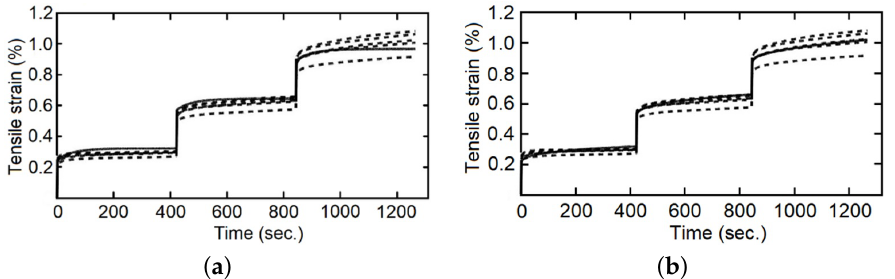
Figure 11. Tensile strain for staggered fluency test, five specimens with 9 wt%, experimental data in dotted lines and model response in continuous line, ( a ) integer index model, ( b ) fractional in- dex model.